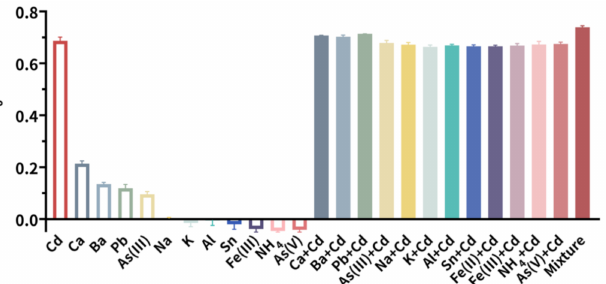
Figure 6. Selectivity of the aptasensor towards other potential interfering ions in absence and presence of Cd 2+ . The concentration of Cd 2+ was 200 ng mL − 1 , and that of all other ions was 400 ng mL − 1 . (n ≥